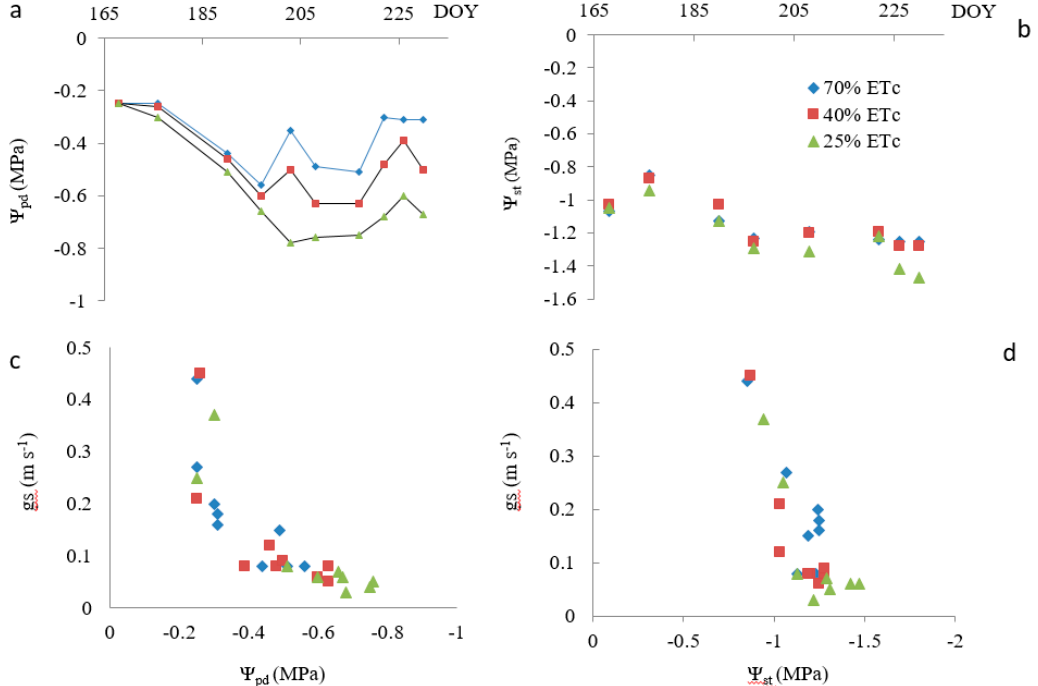
Figure 1. Seasonal course (2009) of ( a ) Ψ pd and ( b ) Ψ st, with the relationships between those variables and noon stomatal conductance (gs); respectively ( c , d ), for the treatments ( ◊ , 70% ETc; □ , 40% ETc; ∆ , 25% ETc) developing approximately to a weak, mild and severe water stress (see text for corresponding Ψ pd ranges). The standard deviations of means are approximately within symbol width. Vineyard (Beja, Portugal).